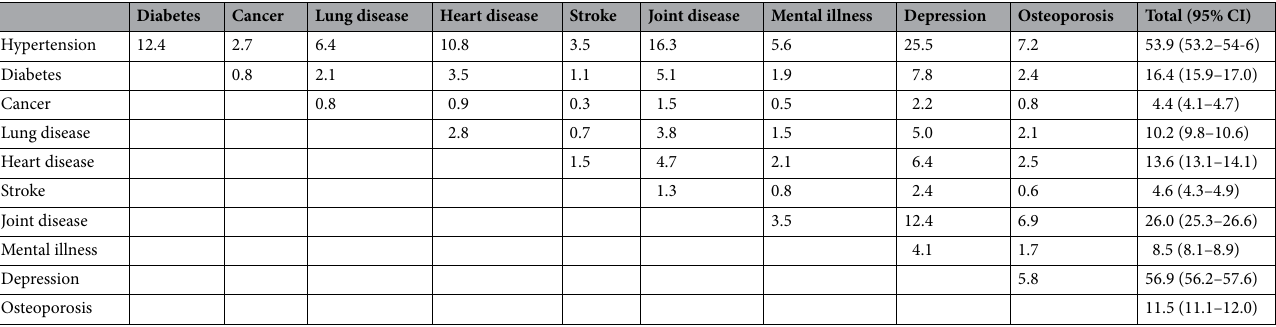
Table 1. Population proportion in every comorbidities